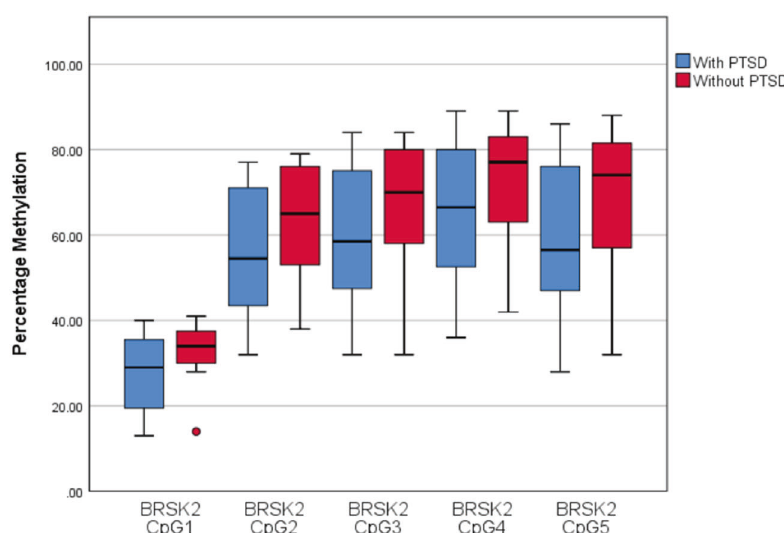
Fig. 1 Posttraumatic stress disorder (PTSD) status and BRSK2 methylation percentage. Boxplots indicating methylation levels between participants with and without PTSD for the fi ve CpG sites in the BRSK2 region found to be associated with PTSD at 3-months post-rape in the epigenome-wide association study.